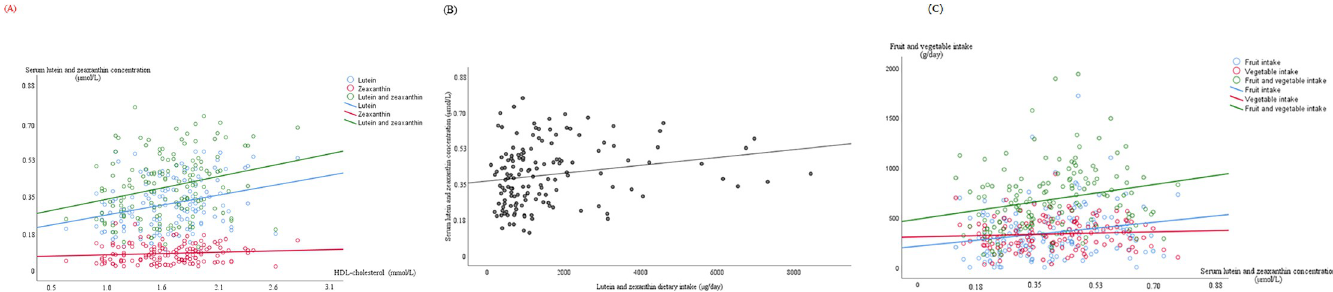
Fig 1. Statistically significant correlations between serum lutein and zeaxanthin concentrations with HDL-cholesterol. (A) and with their total dietary intake (B) and with their major food sources (C) (n = 145, 94 women and 51 men).